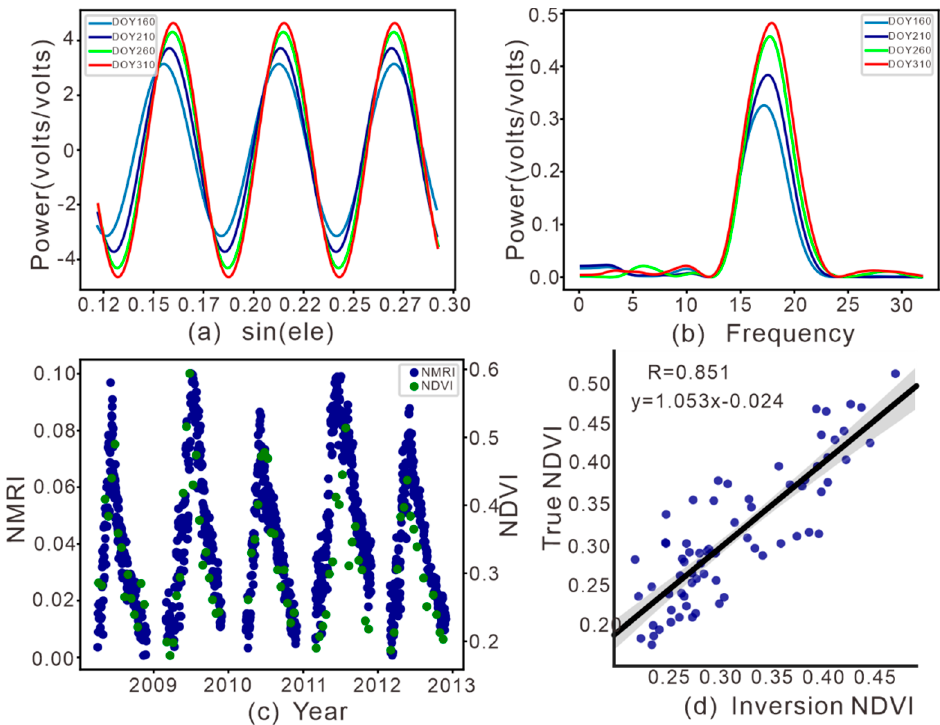
Figure 5. ( a ) The nonlinear least square cosine fitting diagram with the typical characteristics of four days during the experimental period. ( b ) The upper right figure is the L-S spectrum analysis diagram at the corresponding time; ( c ) The NMRI-NDVI diagram; ( d ) The inverse NDVI linear regression diagram.